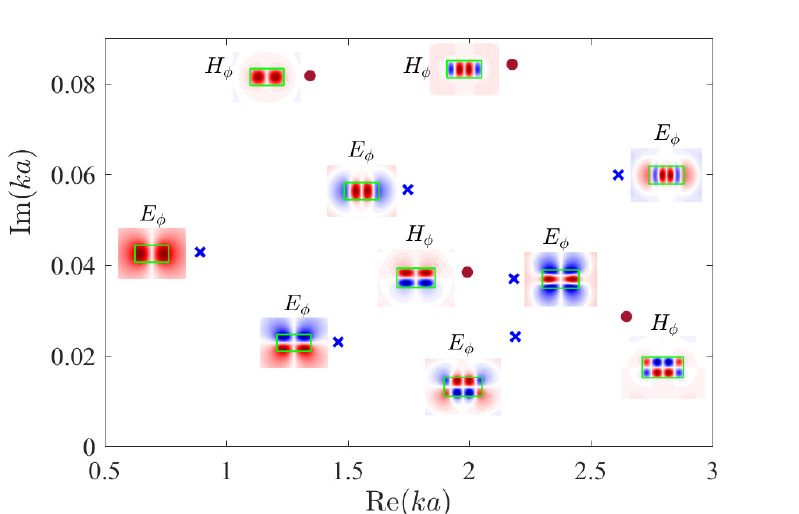
Figure 1. The resonant eigenfrequencies and corresponding resonant modes of dielectric disk with radius a equaled to its thickness h and permittivity (cid:101) = 12 in silicon at λ = 1.5 µ m. The TE/TM resonances are marked by crosses/closed circles. Thin green lines show